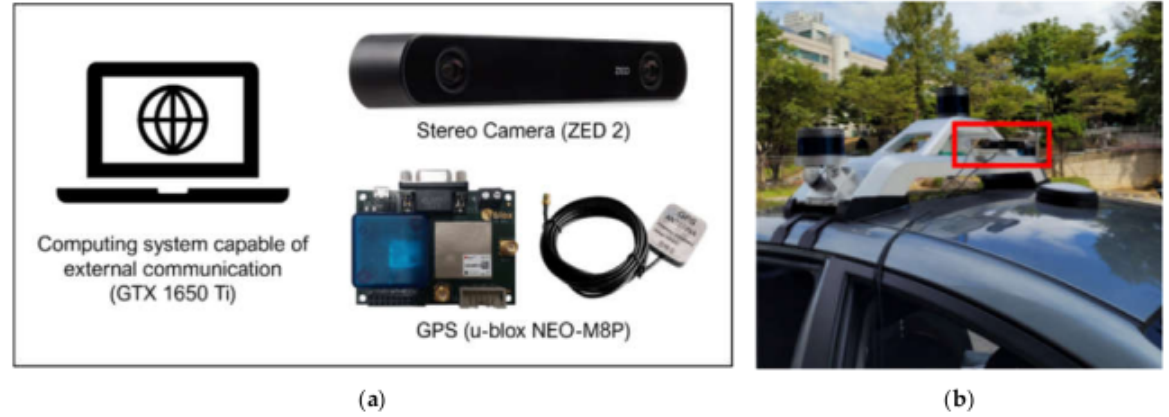
Figure 2. Mounting the collection system on the actual vehicle. ( a ) Configuration of data collection system. ( b ) Data collection